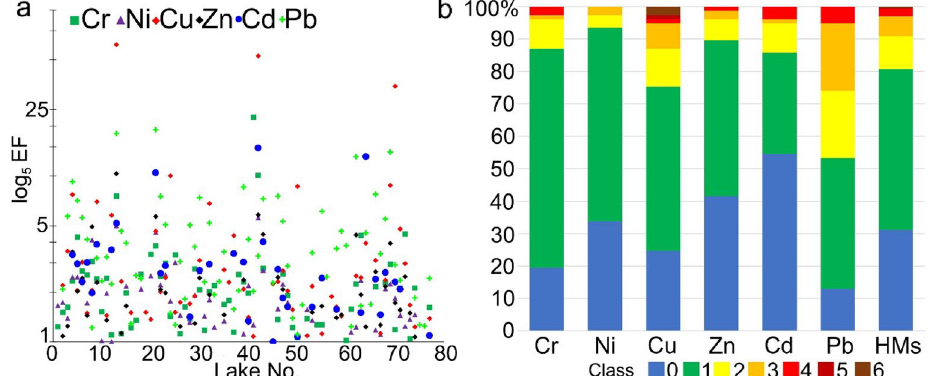
Figure 4. EF index values higher than 1 ( a ) with the classification of the state of pollution of surface sediments ( b